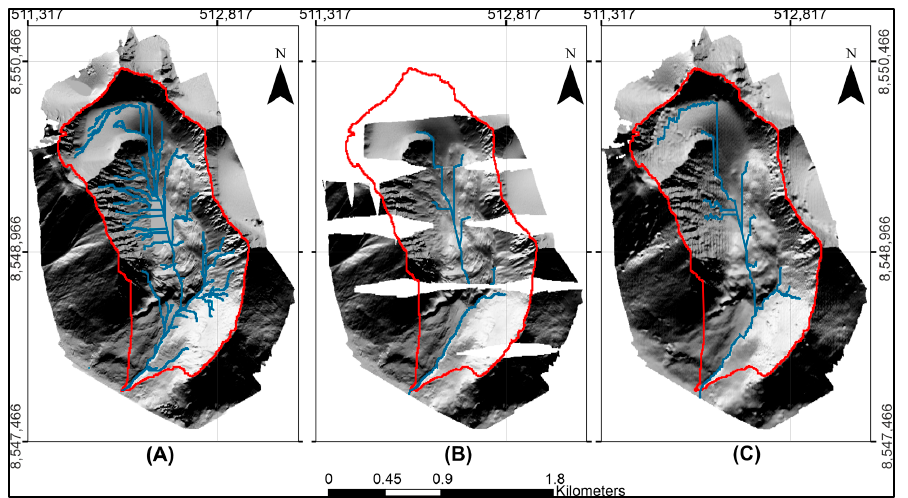
Figure 9. Delineated stream network in Ariebekken catchment. The drone DEM ( A ) has delineated many small streams, and although SIOS DEM ( B ) has better resolution, ArcticDEM ( C ) has better delineation because of data gaps in SIOS DEM. The red polygon marks the catchment boundary.